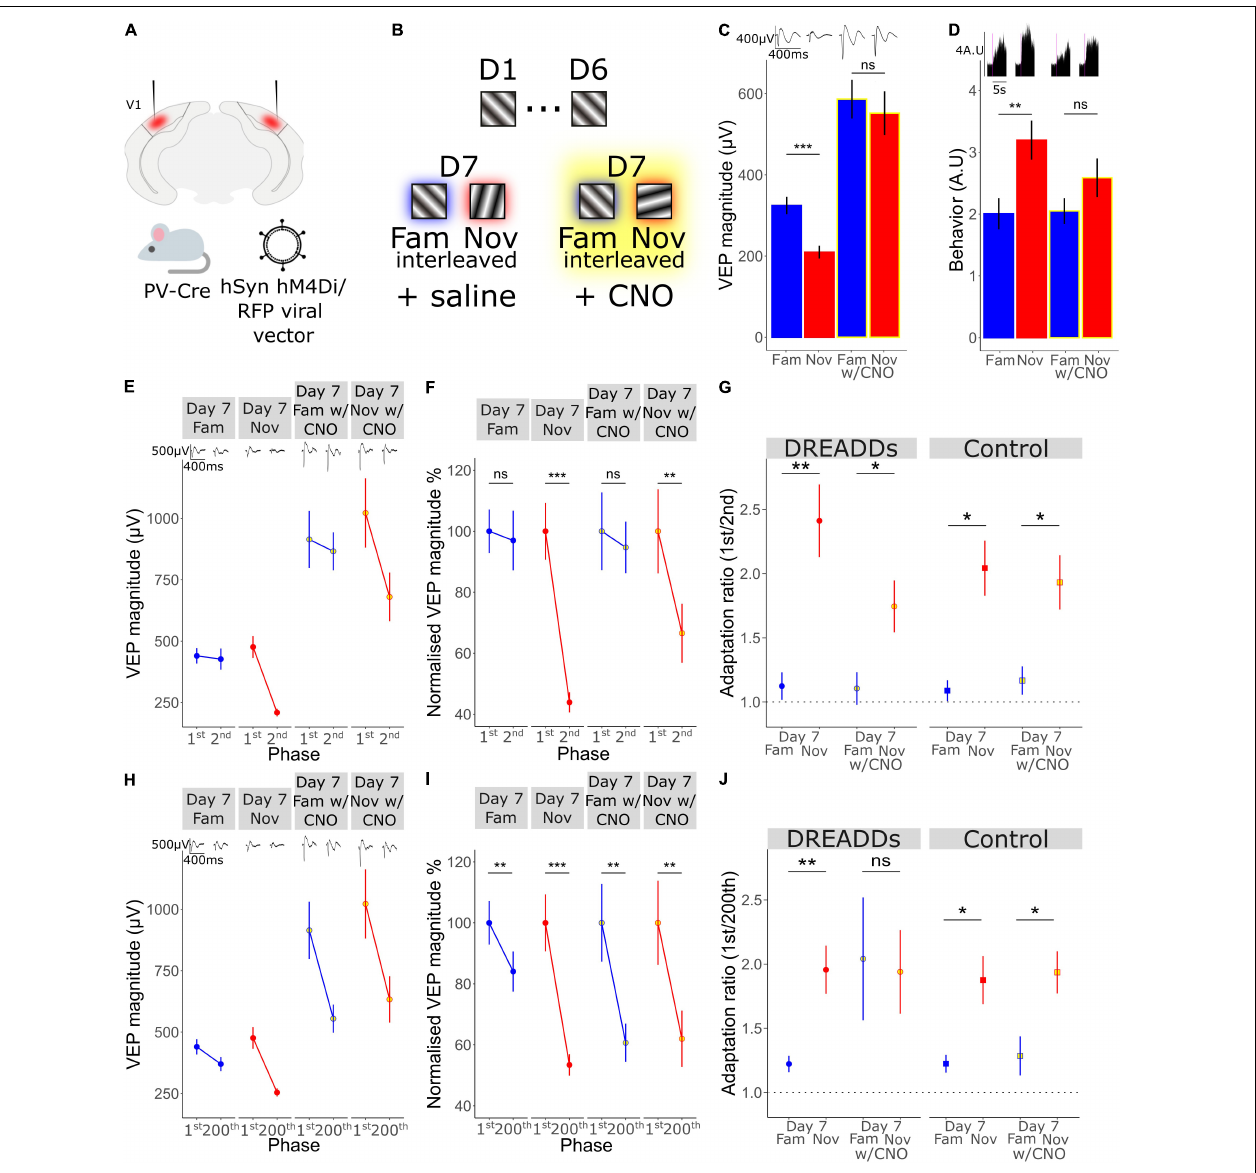
FIGURE 5 | A key role for the activity of Parvalbumin-expressing inhibitory interneurons in long-term familiarity exposes a mechanistic difference between timescales of adaptation. (A) Schematic of the experimental set-up in which hM4Di was selectively expressed in parvalbumin-expressing (PV) inhibitory neurons of V1 using an AAV viral vector in PV-Cre mice. (B) Schematic of visual presentation protocol in which all mice underwent a standard 6-day SRP protocol before testing response to familiar and novel stimuli during systemic saline injection or CNO application, which were administered prior to presentation of familiar and novel stimuli. (C) VEP magnitude in response to familiar and novel stimuli with and without CNO-induced PV+ neuronal inactivation. Wilcoxon signed rank day 7 fam vs. nov: p < 0.001. Wilcoxon signed rank day 7 fam vs. nov with CNO: p = 0.09. (D) Behavioral change in response to familiar and novel stimuli with and without CNO. Wilcoxon signed rank day 7 fam vs. nov: p = 0.02. Wilcoxon signed rank day 7 fam vs. nov with CNO: p = 0.2. (E) VEP magnitude in response to the 1st and the 2nd phase reversal for familiar and novel stimuli with and without CNO. (F) VEP magnitude to the 1st and the 2nd phase reversal normalized to the 1st phase reversal in response to familiar and novel stimuli with and without CNO. Wilcoxon signed rank phase 1 vs. 2 on day 7 fam ( n = 14): p = 0.5, day 7 nov: p < 0.001, day 7 fam w/CNO: p = 0.9, day 7 nov w/CNO: p = 0.004. (G) Adaptation ratio (1st/2nd) in response to familiar and novel stimuli with and without CNO. Wilcoxon signed rank ( n = 14): day 7 fam AR vs. day 7 nov AR in DREAADs group: p = 0.007; day 7 fam w/CNO AR vs. day 7 nov AR w/CNO in DREAADs group: p = 0.02. Wilcoxon signed rank ( n = 7): day 7 fam AR vs. day 7 nov AR in WT group: p = 0.03; day 7 fam w/CNO AR vs. day 7 nov AR w/CNO in WT group: p = 0.02. FDR correction for multiple comparisons. (H) VEP magnitude in response to the 1st and the 200th phase reversal in response to familiar and novel stimuli with and without CNO. (I) VEP magnitude to the 1st and the 200th phase reversal normalized to the 1st phase reversal in response to familiar and novel stimuli with and without CNO. Wilcoxon signed rank phase 1 vs. 200 on day 7 fam: p = 0.005, day 7 nov ( n = 14): p < 0.001, day 7 fam w/CNO: p = 0.005, day 7 nov w/CNO: p = 0.003. (J) Adaptation ratio (1st/200th) in response to familiar and novel stimuli with and without CNO. Wilcoxon signed rank day 7 fam AR vs. day 7 nov AR in DREAADs group ( n =